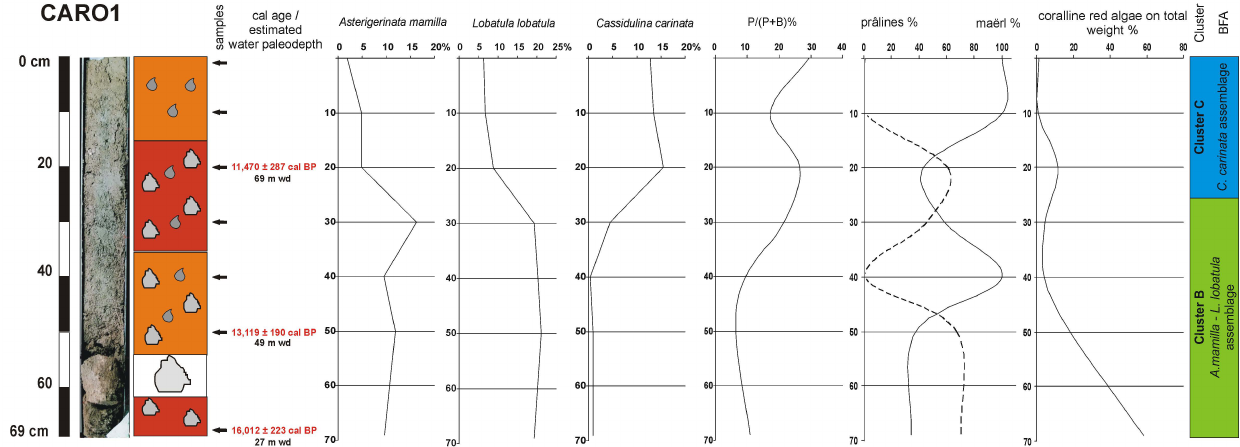
Figure 8. Summary of main data of core Caro1: lithology; calibrated radiocarbon dating (yr BP); estimated water paleodepth (according to the sea-level rise curve of [66]); distribution of must abundant benthic foraminiferal species along the core ( Asterigerinata mamilla , Lobatula lobatula and Cassidulina carinata ); P/(P + B)%; pr â lines and maërl abundances; percentage of coralline red algae on total weight; distribution of clusters recognized from Q-mode HCA (cluster B: light green; cluster C: light blue) and relative benthic foraminiferal assemblages